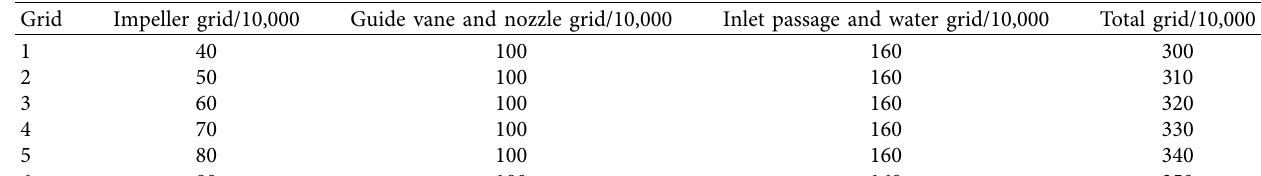
Figure 3: Block structured grid of water jet propulsion pump device. (a) Inlet passage. (b) Impeller. (c) Guide vane. (d) Nozzle. Table 1: The number of different impeller domain grids.